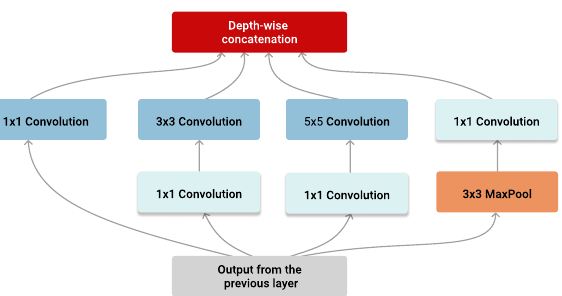
Figure 3. GoogLeNet Inception module. The concatenation layer concatenates outputs x 1 , . . . , x 4 of the four preceding convolutional layers of the shape ( w , h , d i ) , i = 1, . . . ,4, into one volume x (cid:48) = [ x 1 , . . . , x 4 ] of the shape ( w , h , ∑ 4 d i ) , which is forwarded to the following network’s i = 1